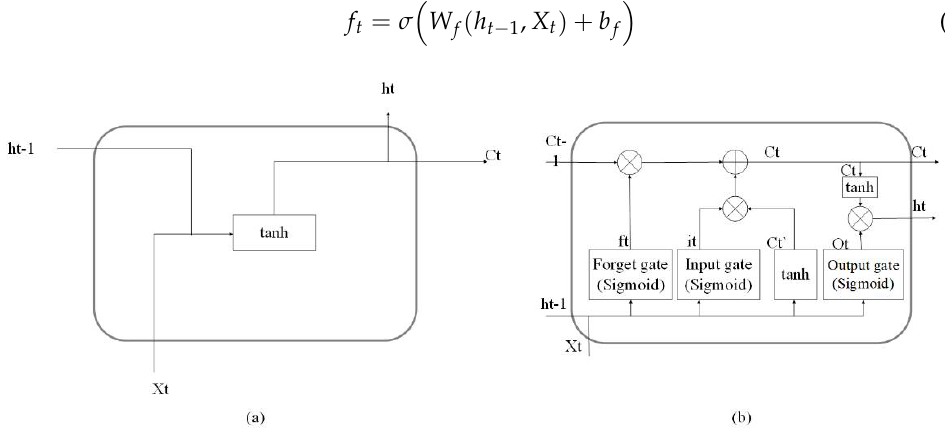
Figure 2. The difference on structural units between RNN ( a ) and LSTM ( b ). The input gate ( i t ) represents the information to be saved or the information to be updated, which is the result of the connection vector of h t − 1 and the current input vector X t after the sigmoid layer